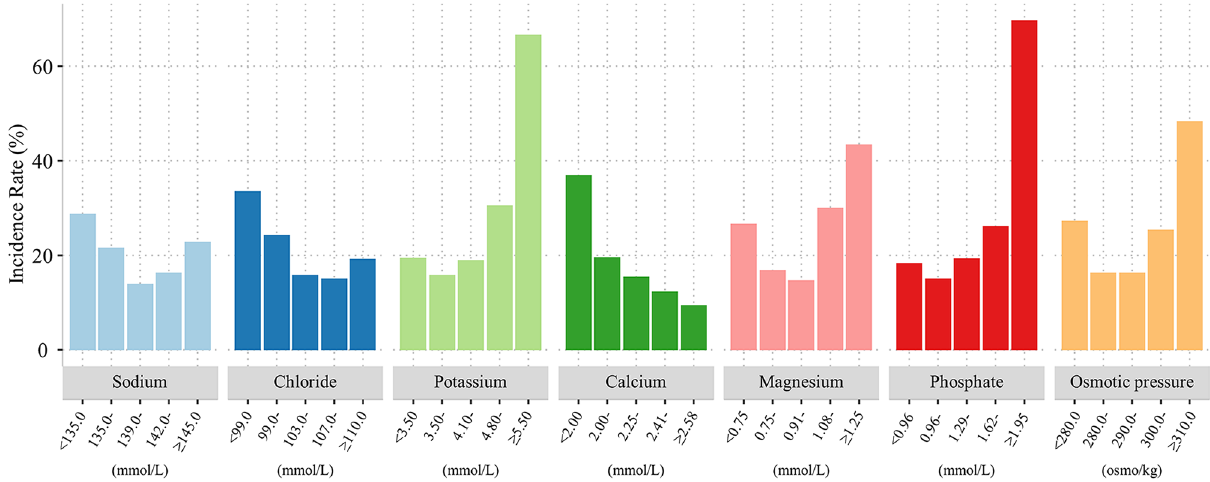
Figure 2. The incidence of CA-AKI in each category of electrolytes and osmotic pressure. All patients were divided into fifth according to the pre-defined cut-off